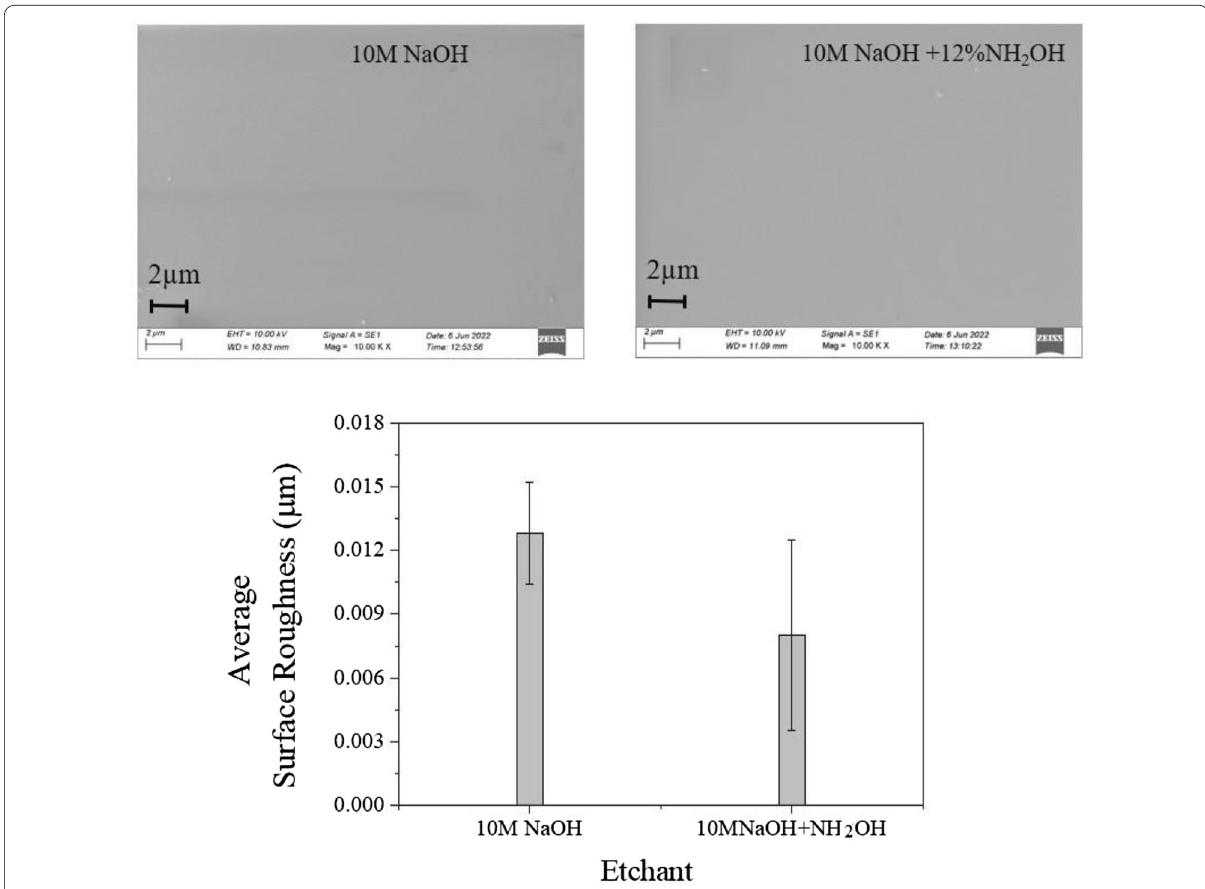
Fig. 6 Average surface roughness and corresponding SEM micrographs of Si{111} etched in pure and NH 2 OH-added